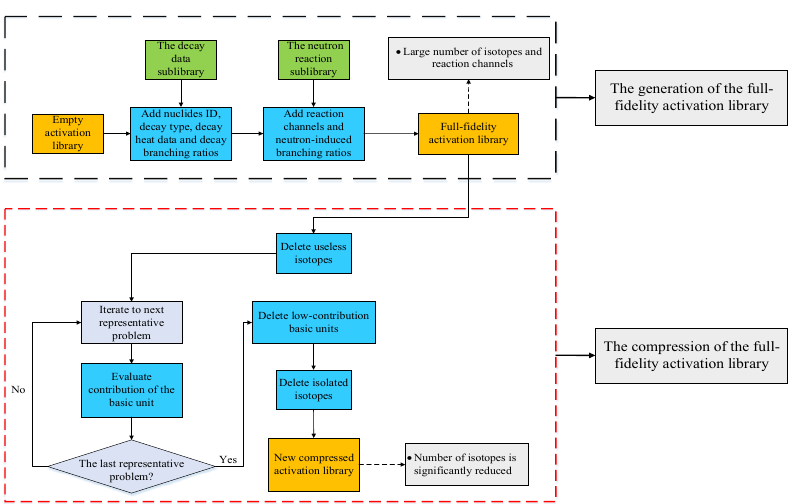
Figure 2. Flowchart of the NECP-X activation library generation and compression system